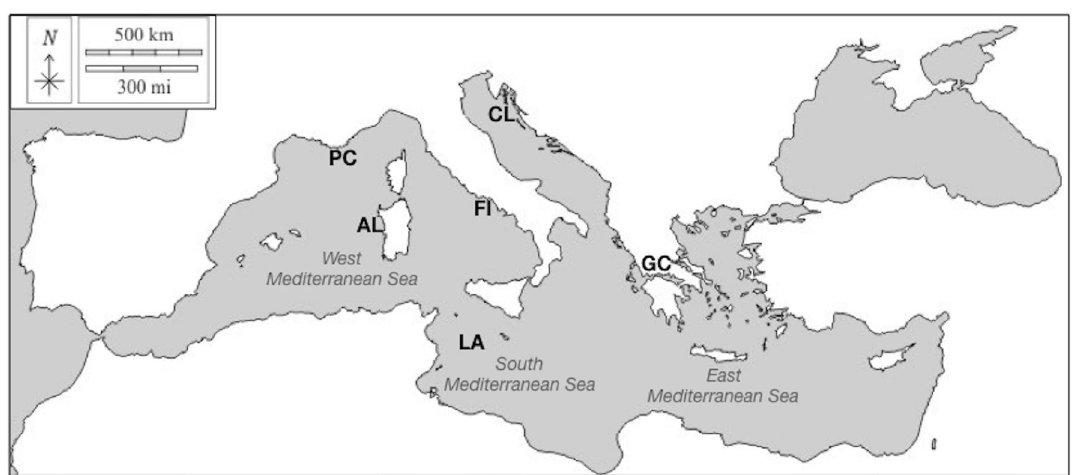
Figure 7. Map of the six study sites in the Mediterranean Sea. PC (Port Cros); Al (Alghero); FI (Ostia- Fiumicino); LA (Lampedusa); GC (Gulf of Corinth); CL (Cres and Losjni). The original map was downloaded from the free source https://d- maps. com/ and modified by Preview in Mac